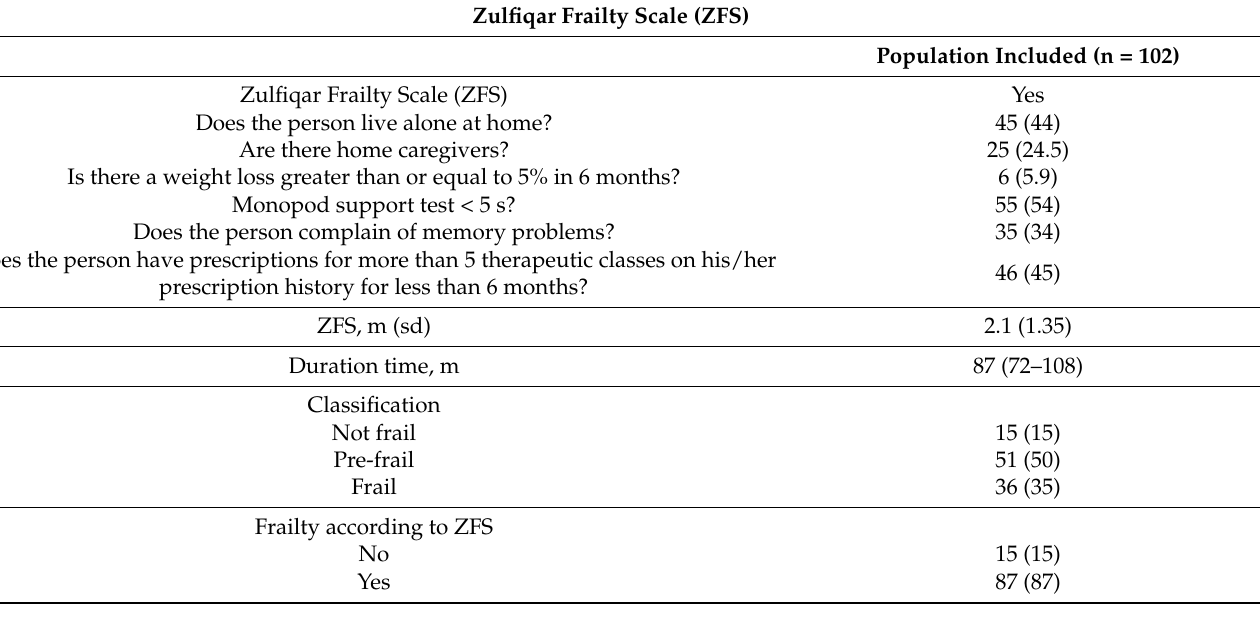
Table 5. mSEGA scale grid